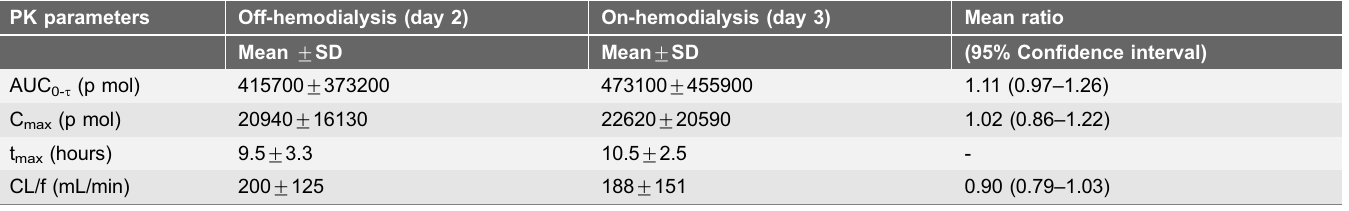
Table 3. Pharmacokinetic parameters of liraglutide following subcutaneous administration of liraglutide to diabetic patients with ESRD on the day of on- hemodialysis and off-hemodialysis. PK